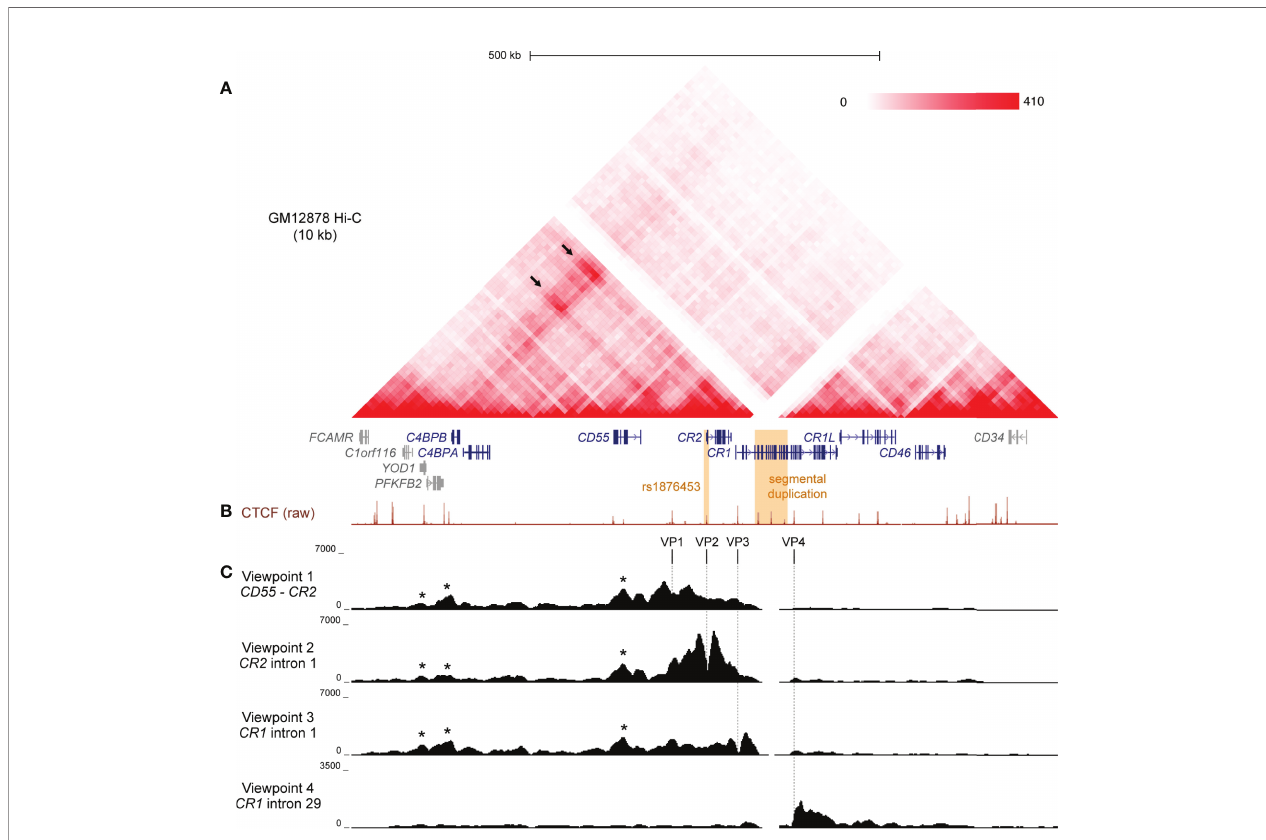
FIGURE 1 | Chromatin conformation of the RCA gene cluster in B cells. (A) Hi-C heatmap matrix (10 kb resolution) for the GM12878 B cell line from Rao et al. (41) for the 1 Mb region across the RCA genes (dark blue) on hg19 (chr1:207,120,000-208,130,000). Relative interaction frequencies between two loci are indicated by colour intensity (range 0-410). High frequency long-range interactions (>350 kb) were observed between distal RCA genes C4BPB and the complement receptor genes ( CR2 and CR1 ) (arrows), as well as between intervening loci, indicating that these genes reside in the same TAD. SLE-associated variants are indicated in orange. (B) GM12878 ChIP-seq signal for CTCF from ENCODE shows CTCF enrichment at multiple sites across the RCA gene cluster which may engage in long-range chromatin looping. (C) Chromatin conformation of the RCA gene cluster was fi ne-mapped using 4C-seq in the B-0028 cell line. Maps were generated from four viewpoints on CTCF binding sites in the intergenic region between CR2 and CD55 (viewpoint 1, VP1), intron 1 of CR2 (viewpoint 2, VP2), the intron 1 of CR1 (viewpoint 3, VP3) and intron 29 of CR1 (viewpoint 4, VP4). Viewpoints are represented by vertical dotted lines. Several 4C-seq peaks were common between VP1 – 3 and aligned with CTCF binding sites within YOD1 , upstream of C4BPB and within CD55 (asterisks). VP4 showed a distinct interaction pro fi le to all other